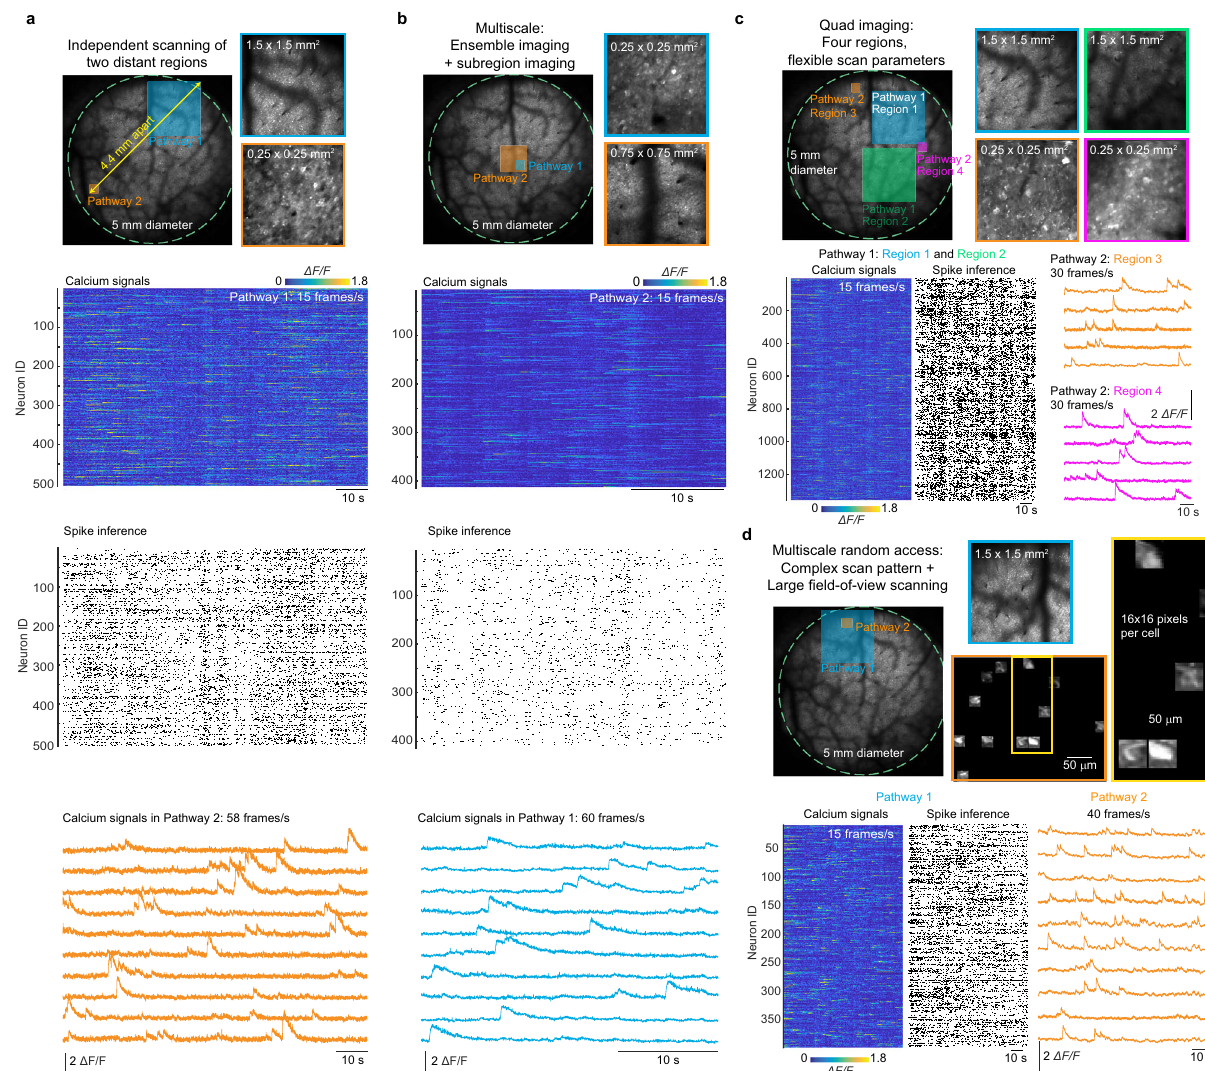
Fig. 3 Flexible measurement with dual independent scan engines. a Neuronal activity at two distant regions (4.36-mm apart) are imaged simultaneously with independent imaging parameters. The blue and orange boxes indicate the imaging sizes and positions within the full FOV. Expanded regions are shown at right. Calcium signals from 500 neurons imaged in Pathway 1 were used to infer spikes. Simultaneously, Pathway 2 imaged calcium signals at 58 frames/s 4.36 mm away. b Neuronal activity from two overlapped regions are imaged simultaneously with different imaging parameters. Over 400 neurons were imaged in Pathway 2 while neural activity was imaged at 60 frames/s in Pathway 1. c Neuronal activity from four separate regions are imaged with two pathways independently positioned and then repositioned within the full FOV. By serially offsetting the galvo scanners, Pathway 1 accesses the blue and green regions, and Pathway 2 accesses the orange and the magenta regions. By changing the curvature of the AO, Pathways 1 and 2 also image at different depths. Calcium signals and inferred spike trains from neurons in the Pathway 1 data (Region 1 and Region 2 combined) are shown. Example calcium signals are shown for neurons from Region 3 (orange) and Region 4 (magenta) scanned by Pathway 2. d A combination of raster scanning and random-access scanning is con fi gured on Pathways 1 and 2 for neuronal imaging. While Pathway 1 performs raster scanning, Pathway 2 performs random-access scanning for 12 cell bodies. Calcium signals and the inferred spike trains are shown for neurons imaged by Pathway 1. Example calcium signal traces are shown for neurons imaged by Pathway 2